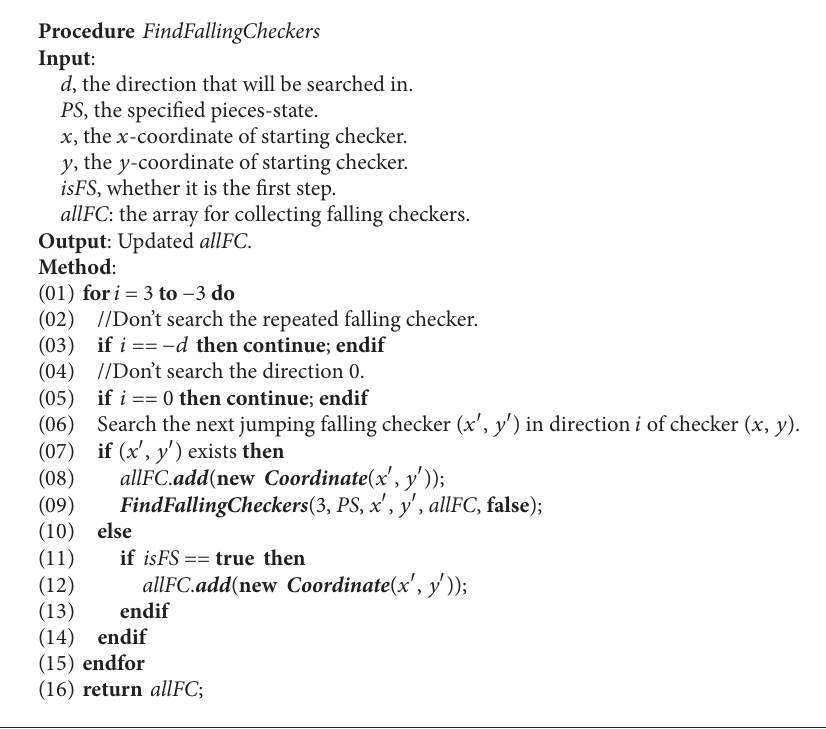
Algorithm 8: FindFallingCheckers .